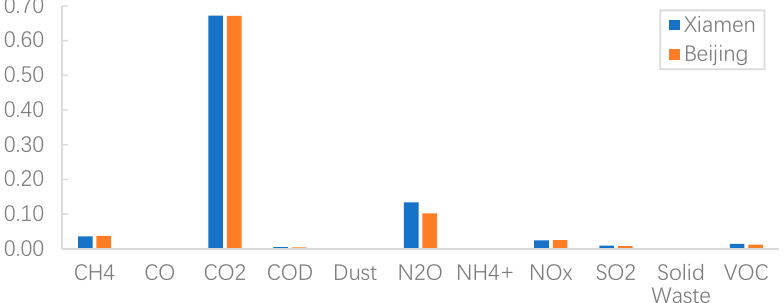
Figure 2. Sensitivity coefficients of the unit virtual abatement costs.